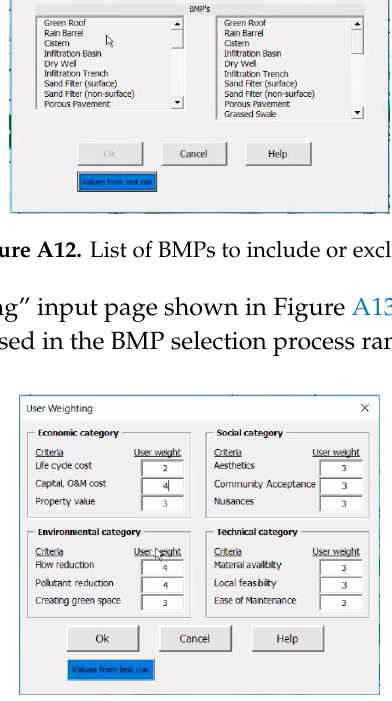
Figure A14. Output of BMP selection module The BMP sizing module : For the purpose of sizing, BMPs have been categorized into three different groups including green roof system, infiltration based BMPs such as bioretention and storage-based BMPs such as detention and retention pond (Figure A15). Figure A15. BMP sizing module